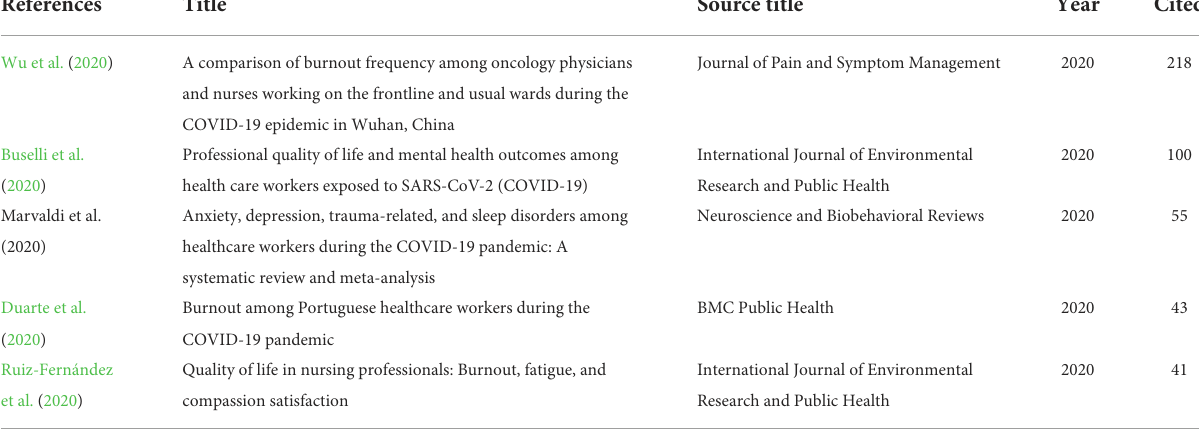
TABLE 1 Top 5 most global and local cited publications (2020).